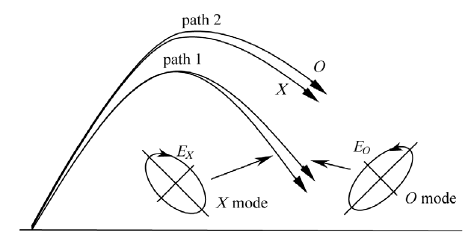
Fig. 13.1. Multipath and multimode propagation in the